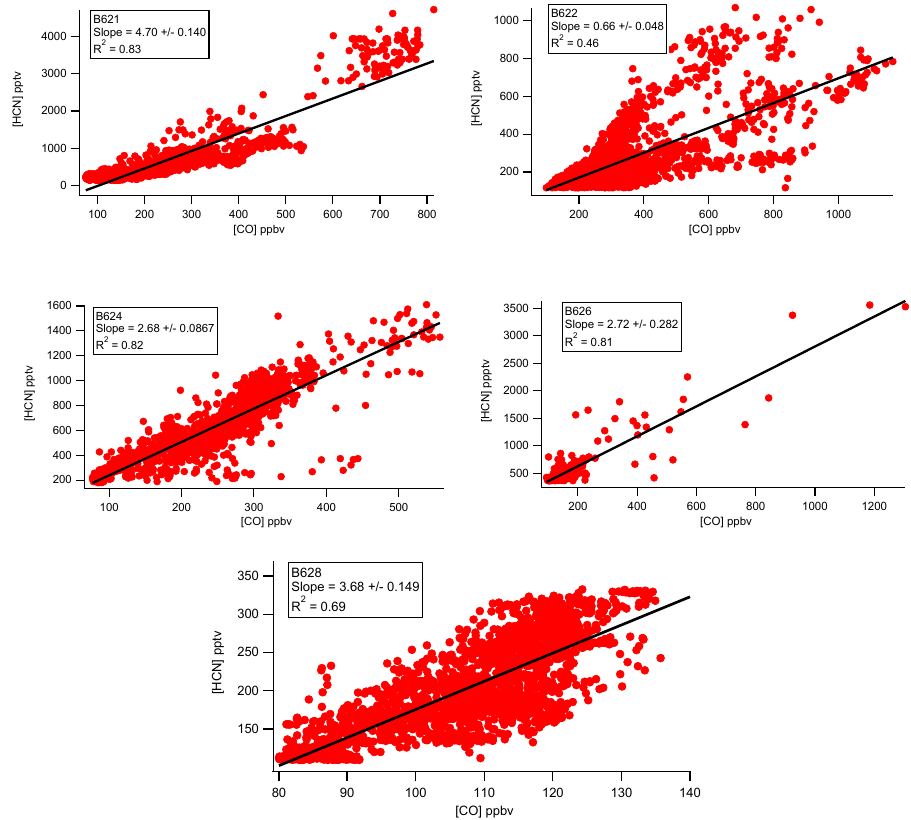
Fig. 4. HCN:CO correlations in plume determined by the 6-sigma HCN approach for 5 flights during the BORTAS campaign.